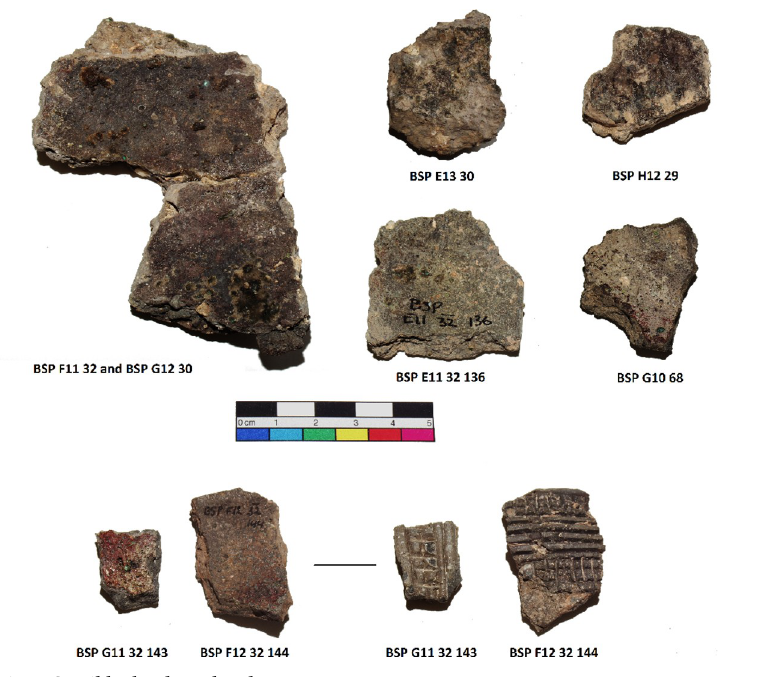
Fig 2. Crucible sherds